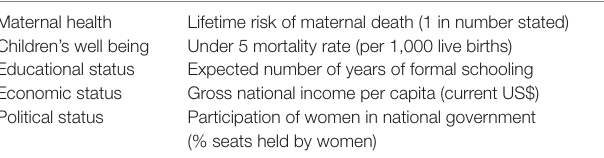
TABLe 6 | Mother’s Index metrics used by Save the Children Foundation.